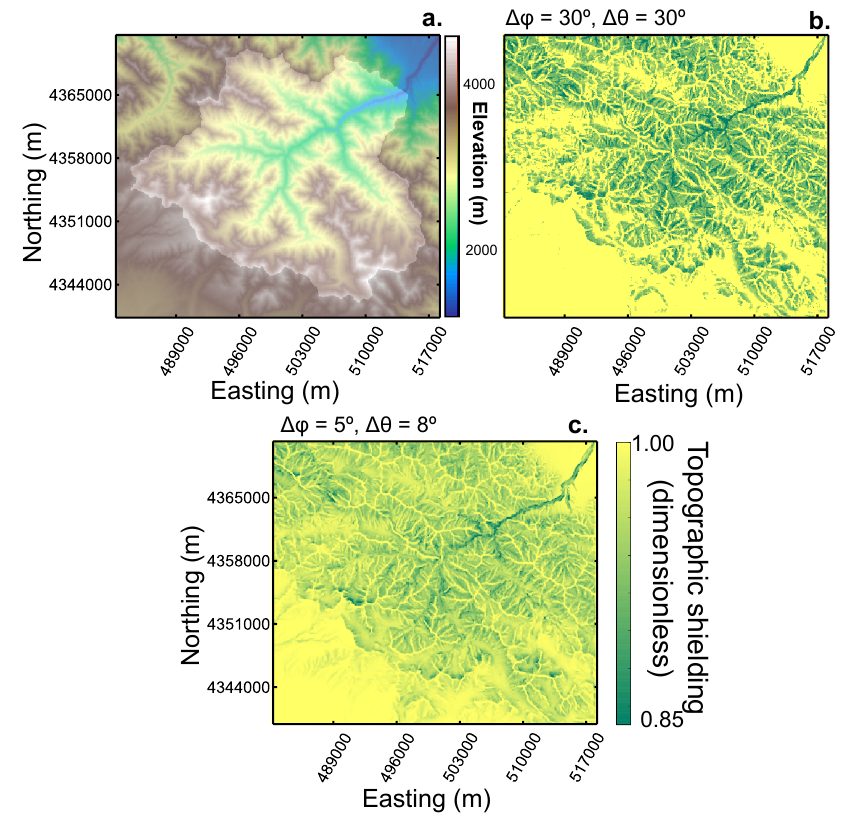
Figure 4. Comparison of the topographic shielding for different values of (cid:49)φ and (cid:49)θ . The Tibetan basin is for sample 07C13 in Palumbo et al. (2011). Maps are projected into WGS1984, UTM zone 47N. The basin is shown in plot (a) , whereas the topographic shielding factor is shown in plots (b) and (c)